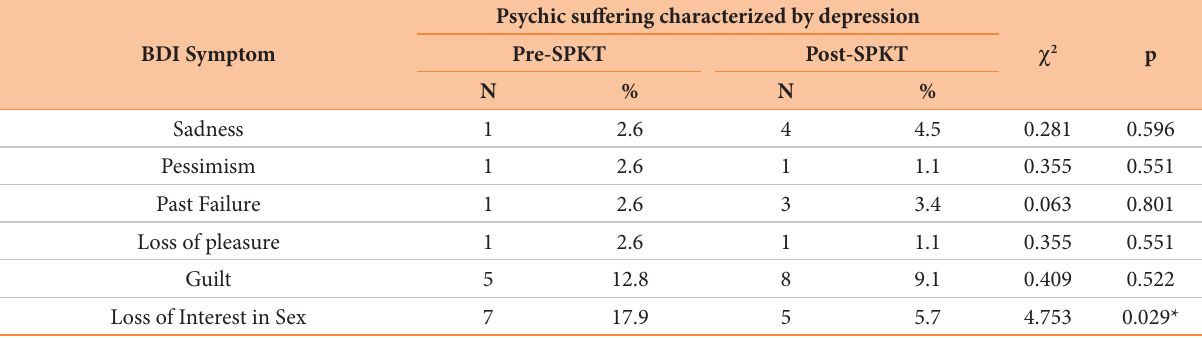
Table 4 - Comparison of the 21 variables related to the BDI psychological test between the pre- and post-SPKT groups. BDI